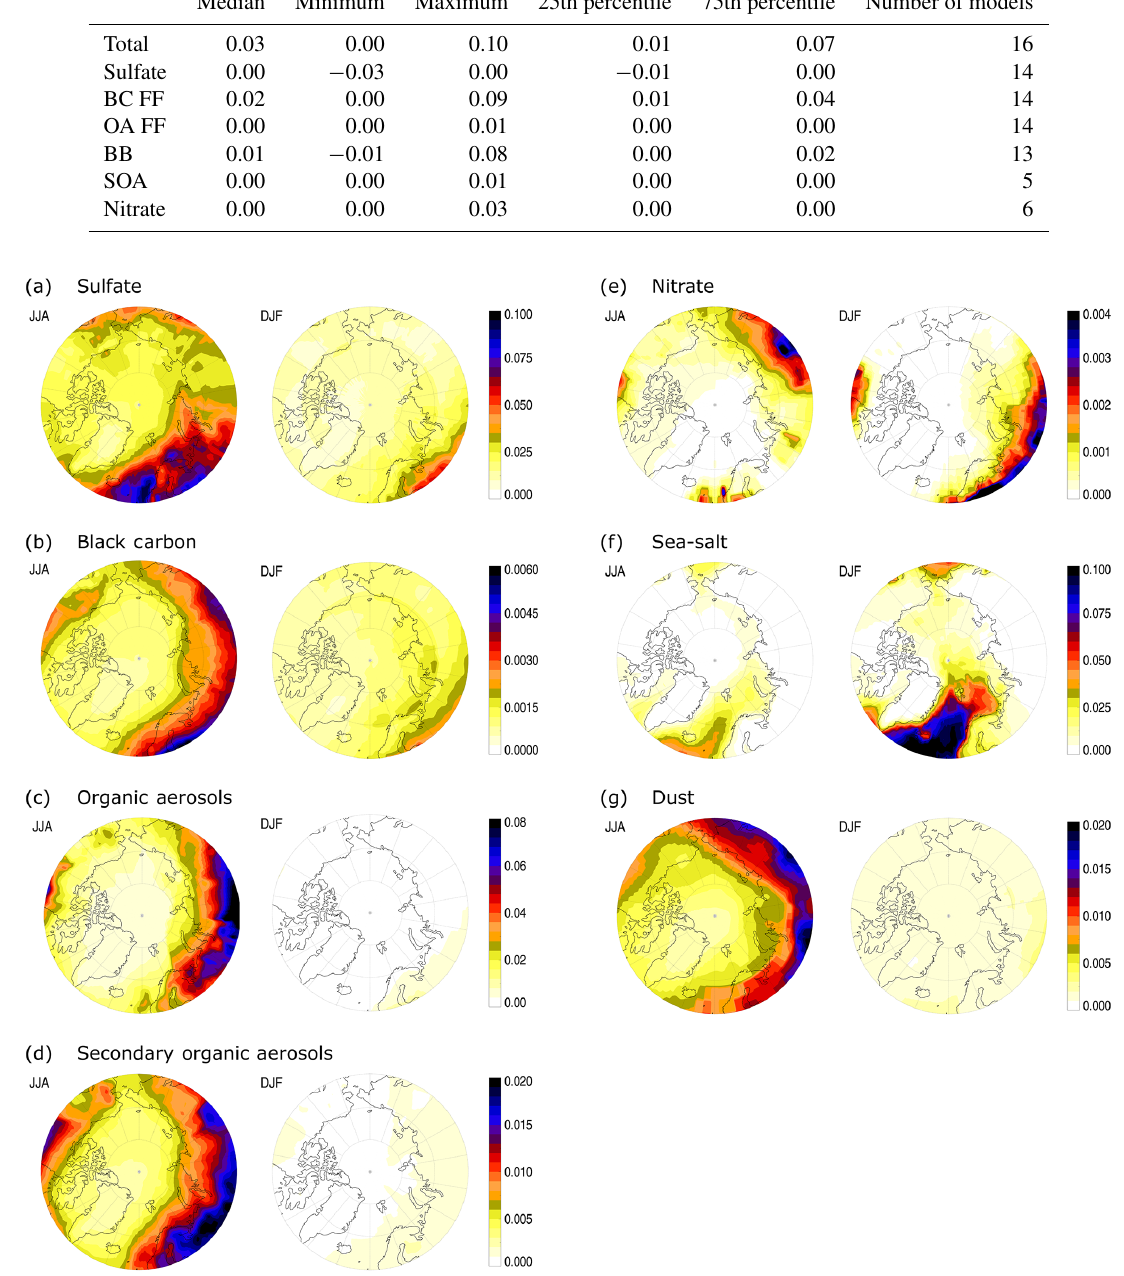
Figure 10. The geographical distributed model-median Arctic AOD (a) sulfate, (b) BC (from all sources), (c) total OA (from all sources), (d) SOA, (e) nitrate, (f) sea-salt, and (g) dust, for the summer (JJA) season (left) and the winter (DJF) season (right). Note the different axes.